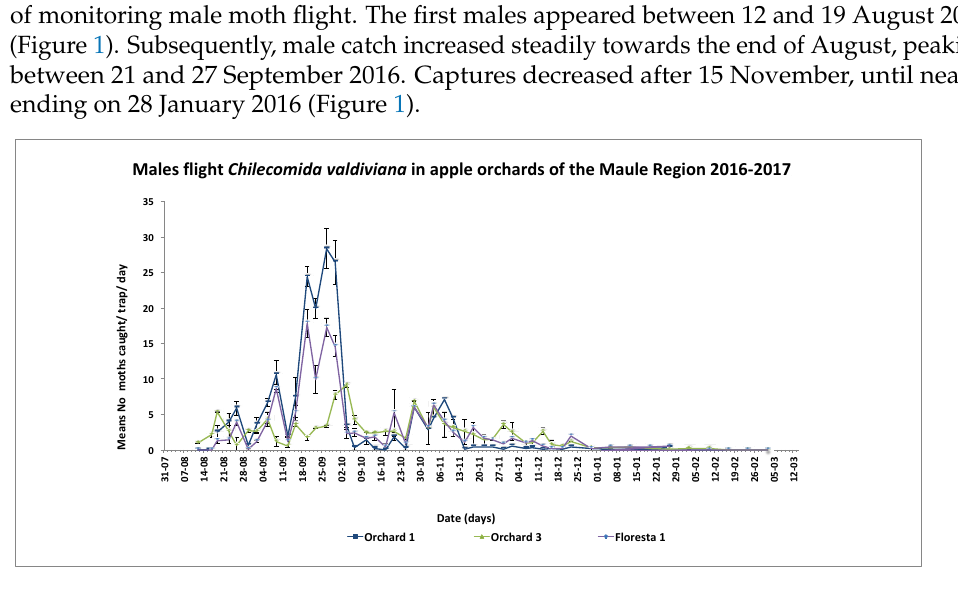
Figure 1. Seasonal flight activity of Chilecomadia valdiviana males monitored with sex pheromone baited bucket traps at three apple orchards in 2016–2017 in the Maule Region, Chile.